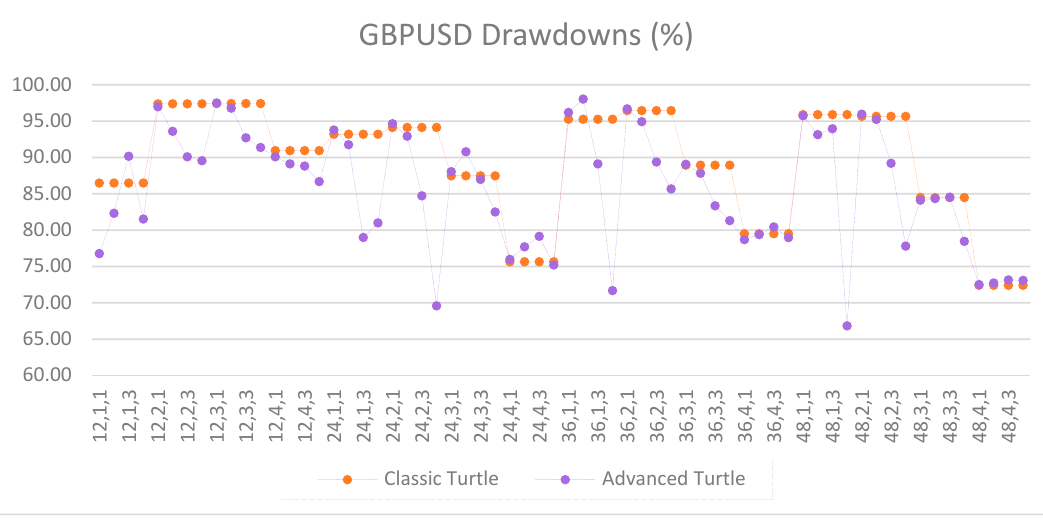
Figure A6. Drawdowns of GBPUSD as percentage of equity between the classic and the advanced Turtle systems for every combination of N, X, Y for the fast parameters (20, 40).